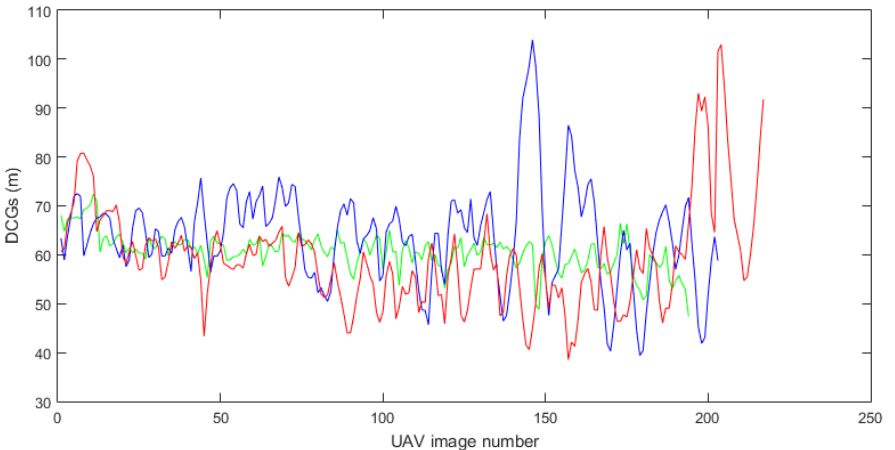
Figure 15 . Slant DCGs to the NDTM from the tilted fake DEM (green), tilted plane DEM (blue) and tilted NDTM (red). The slant distances from the tilted NDTM are simulated with the values of pitch angle – 45 degrees at azimuth 330 degrees.